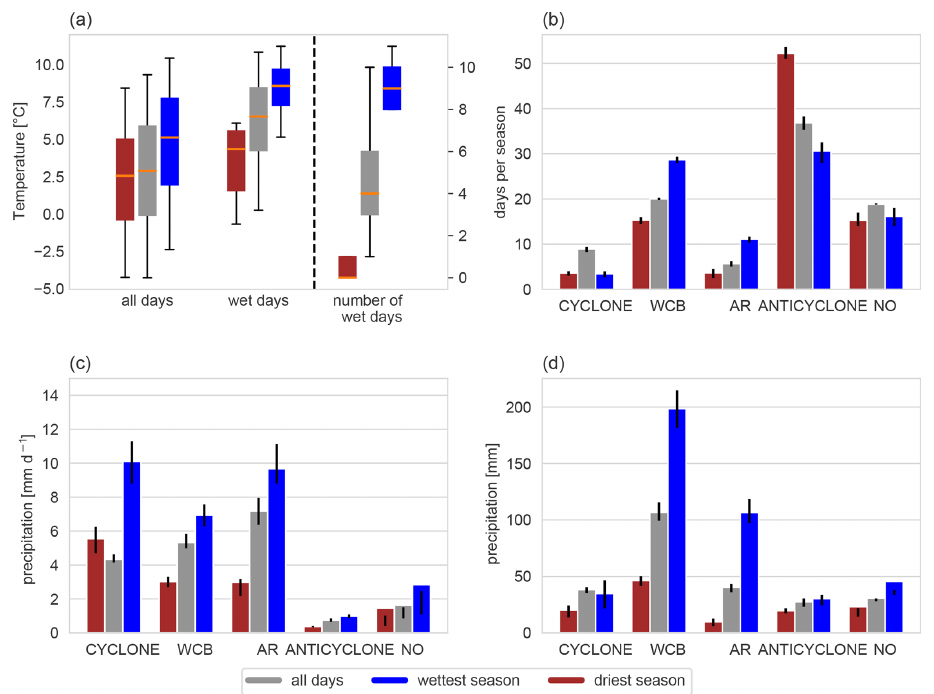
Figure 9. Seasonal analysis for C-EU in winter. (a) T distributions for all days and wet days only, as well as number of wet days, (b) mean weather system frequency on all days, (c) mean weather system precipitation efficiency, and (d) total precipitation associated with each weather system category. The colours denote results for the climatology, i.e all days (grey) and for the wettest (blue) and the driest winter (red). In (a) , the orange line denotes the median, the box values are between the 25th and 75th percentiles, and the whiskers extend from the 5th to the 95th percentile. Black error bars in (b)–(d) denote the inter-quartile range of the 25 grid points in the